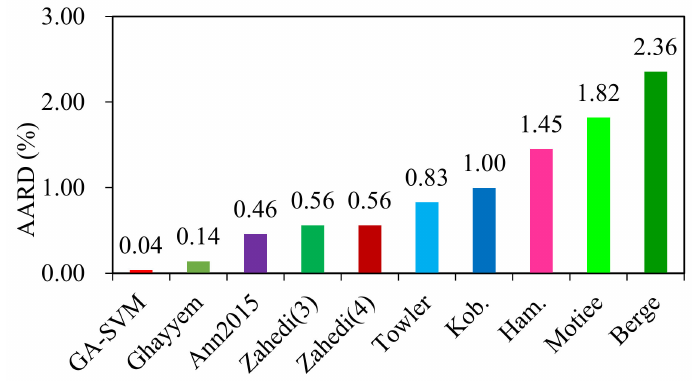
Figure 4. Comparison of mean absolute relative deviation (AARD) for various